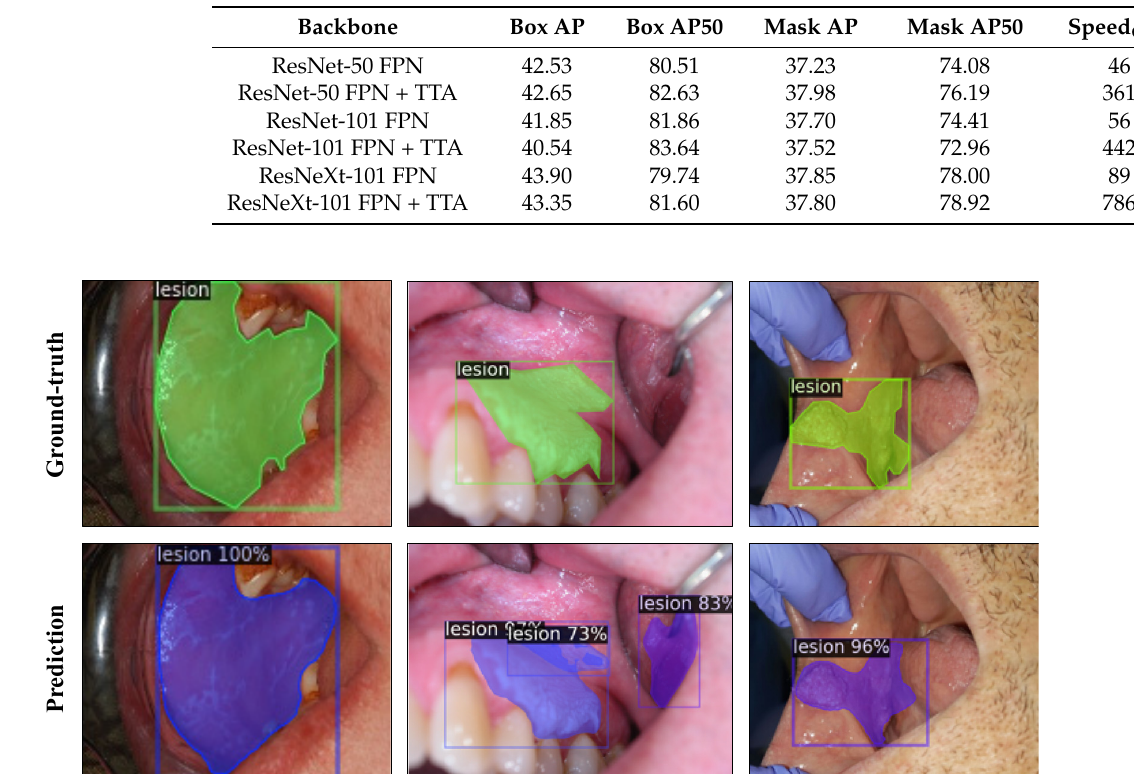
Figure 3. Instance segmentation of oral lesions with Mask R-CNN ResNeXt-FPN model showing ground-truth (top row) and predicted (bottom row) bounding box and segmentation masks for test images. The values printed on top of the predicted boxes are the confidence scores for each prediction. Table 5. YOLOv5 results for lesion detection with the best model checkpoints on the test set. Speed